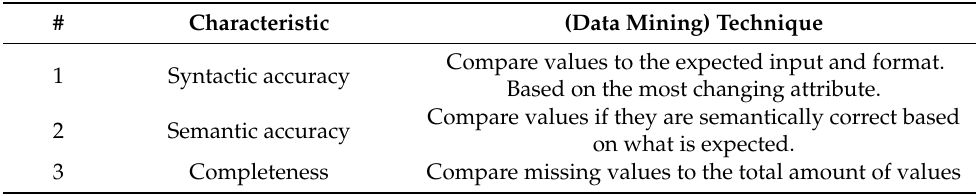
Table 3. RapidMiner queries for each